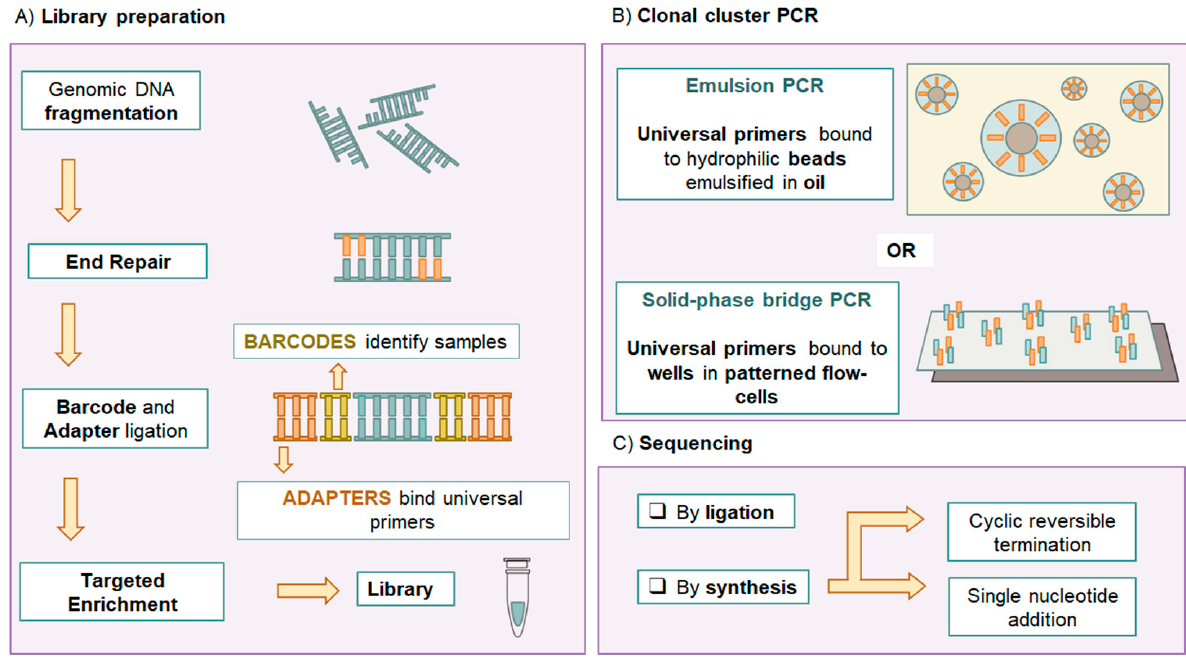
Figure 1. Next Generation Sequencing (NGS) experiment workflow . ( A ) Genomic DNA extracted from the samples is first processed in libraries. Purified genomic DNA is fragmented, then the fragments go through an end-repair phase and barcode and adapters ligation. Barcodes are unique sequences identifying specific samples within a run. Adapters are universal sequences used for PCR amplification and fragment capture. Some protocols require targeted enrichment (with PCR or biotin-streptavidin magnetic pulldown) to capture the desired fraction of the genome. ( B ) The libraries then undergo the crucial step of clonal cluster PCR amplification. This step leads to thousands of identical copies of the original DNA fragments in defined areas, allowing spatial resolution of localized, non-overlapping clonal clusters. This can be done with either emulsion-PCR, on hydrophilic beads emulsified in oil, or Solid-state bridge PCR, in the micro-wells of a patterned flow cell. ( C ) The sequencing reaction can be based on DNA ligase (sequencing by ligation) or DNA synthetase (sequencing by synthesis). The latter is the most common. Sequencing by synthesis can take place by Single Nucleotide Addition or by Cyclic Reversible